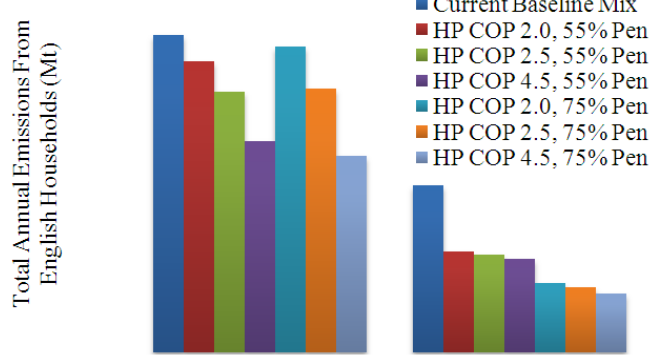
Figure 8. Emissions at different electricity grid emissions factors, heat pump efficiencies and penetration